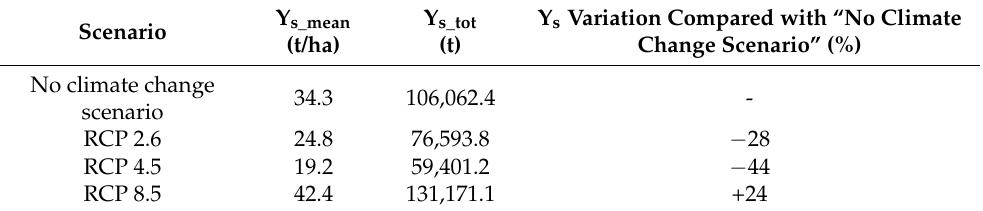
Table 7. Summary of the results: sediment yield generated by the 4 September 2011 rainfall event (MUSLE model) in the Guerna catchment, considering or not the effects of climate change (where AMC II was used to generate surface runoff).